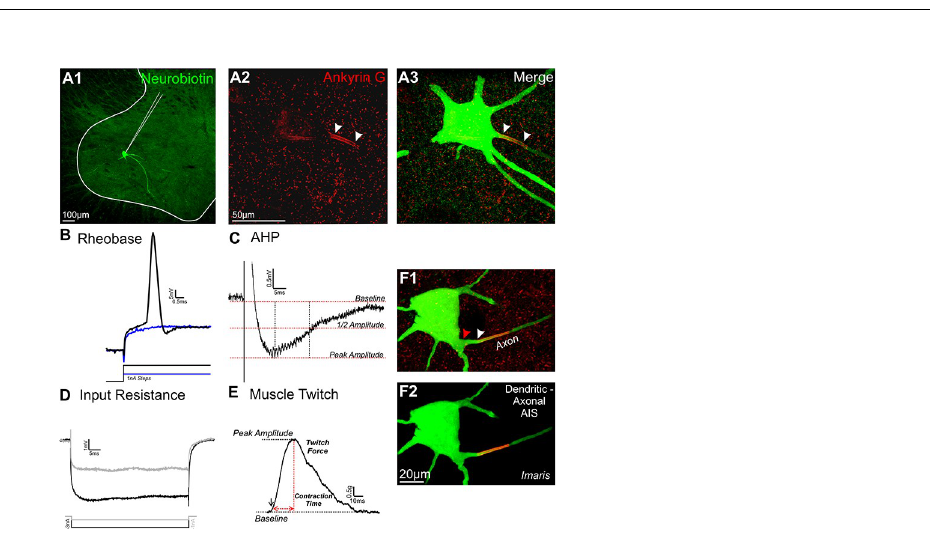
Fig 2. Morphological and in vivo electrophysiological parameters measured in individual Neurobiotin filled motoneurons. (A1) Collapsed confocal image (10x) of a Neurobiotin filled motoneuron in the ventral horn of the spinal cord. Solid white line indicates white/gray matter boundary. (A2-3) High magnification confocal image of AnkG immunoreactivity in ventral horn of the spinal cord (A1). (A3) Image of Neurobiotin filled MG motoneuron revealed with streptavidin-488 merged with AnkG. White arrow heads indicate AIS. (B) Rheobase generated by 50ms square pulse of depolarizing current injection. Blue trace indicates a current injection that did not elicit an action potential. (C) After hyperpolarization (ahp) was elicited via 0.5ms suprathreshold current injection. (D) Input resistance measured by hyperpolarizing currents (-1/3nA) for 50ms. Input conductance is reported as the inverse of resistance. (E) Muscle twitch results from ahp current injection. Twitch force is defined as the maximum amplitude (vertical dashed red line). Contraction time (CT) is measured between the twitch onset to the maximum amplitude (horizontal dashed red line). (F1-2) A small percent (11% in our sample) of axons are of dendritic origin. (F1) Neurobiotin filled motoneuron with a parent dendrite indicated with the red arrowhead and the protruding axon indicated with the white arrowhead. (F2) Merge Imaris rendition of image displayed in F1.